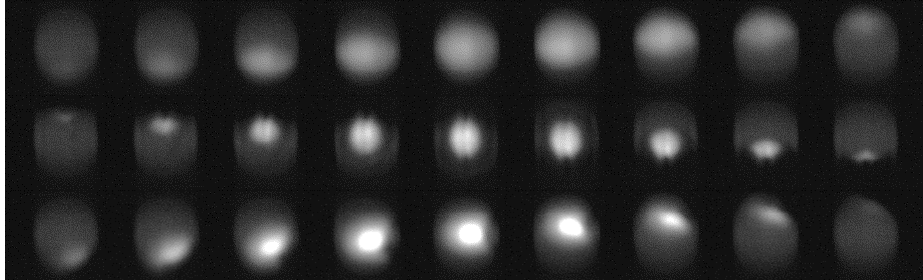
Figure 5. Examples of the appearance of bubbles in the sensor image. ( Upper row ): bubble pass- ing the sensor close to the LED. ( Middle row ): bubble passing the sensor close to the camera. ( Lower row ): bubble passing near the center of the tube. For all images, the same specimen was used, so Hb concentration as well as bubble size are the same.